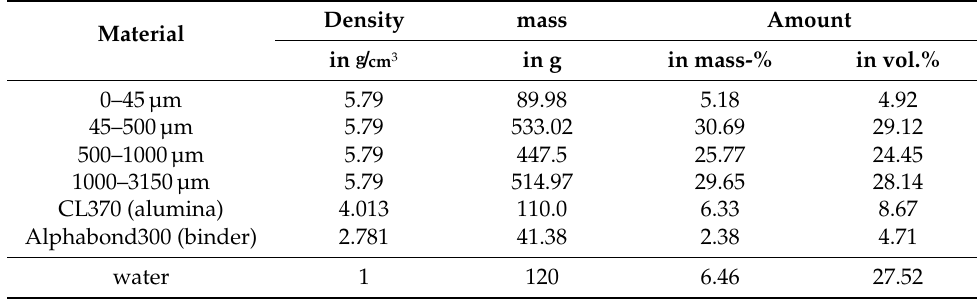
Figure 8. ( a ) Determined particle size distributions of the used castable components as they contribute to the castable’s particle size distribution (calculated sum distribution); ( b ) CPFT of the particles of the coarse-grained castable together with the results of the fit using the modified Dinger-Funk distribution model (see Equation (1)). Table 6. Coarse-grained castable